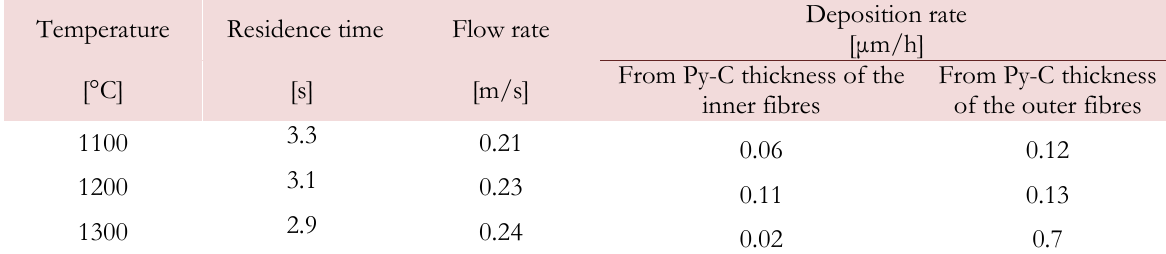
Table 3: steady – state Py-C deposition rates.